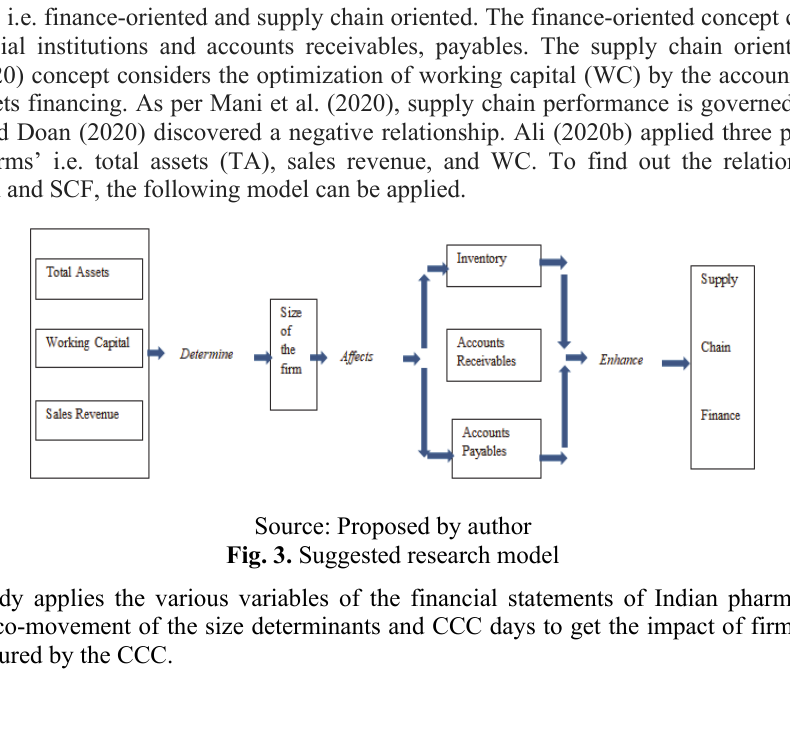
Data description and sources